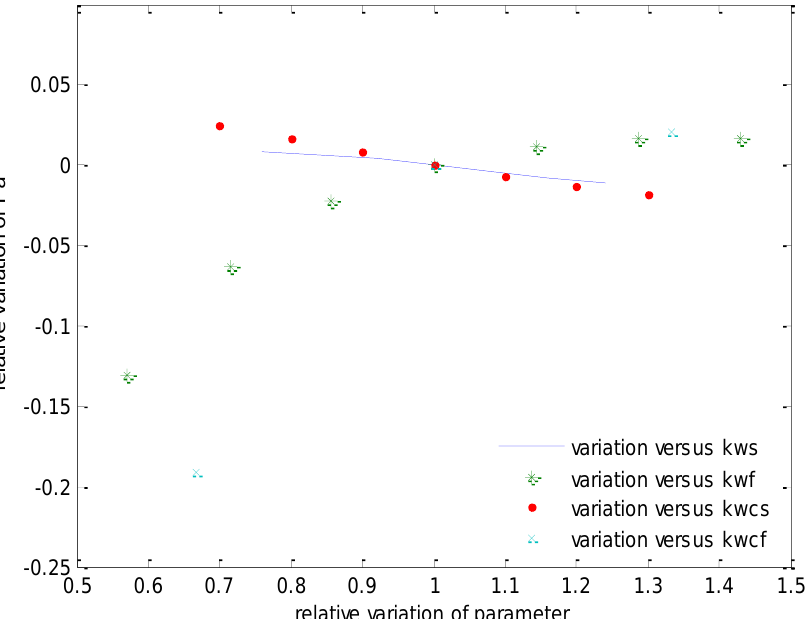
Fig. 7. The relative variation of P a with respect to changes in the parameters: weighted procedure with w (1)= w (19)= w